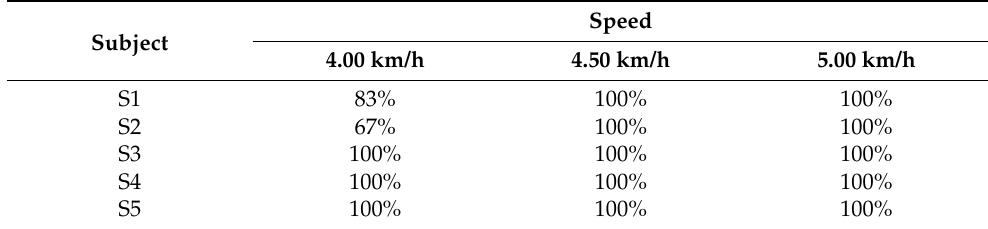
Table 3. Result of the detection of the activity of walking.